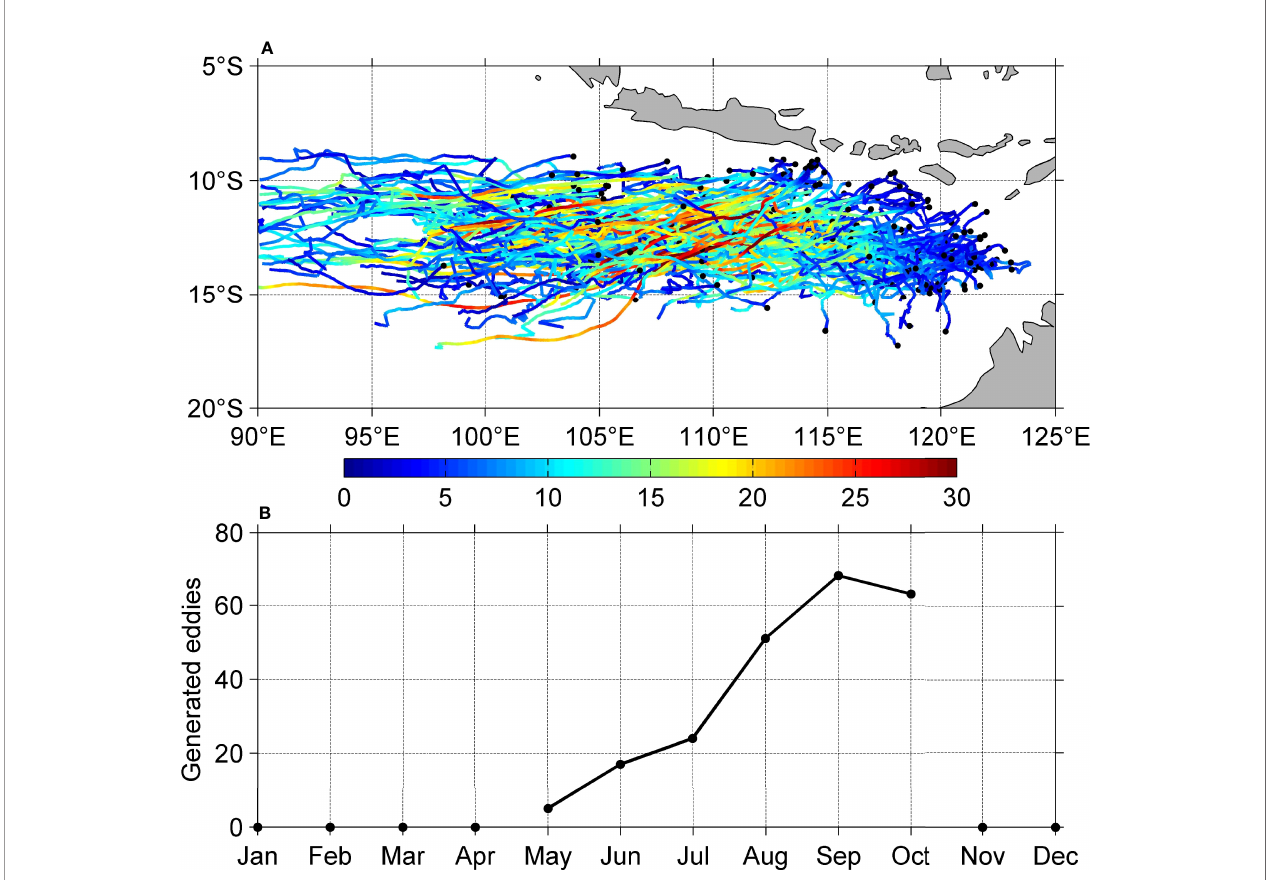
FIGURE 6 | Same as Figure 5 but for eddies passed through the strong seasonality area in October. (B) Variation of the number of generated eddies in (A)